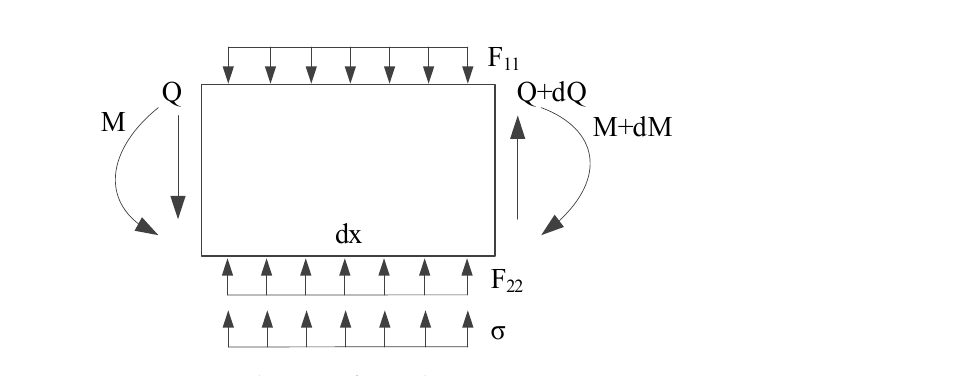
Figure 4. Force diagram of tunnel micro-unit.